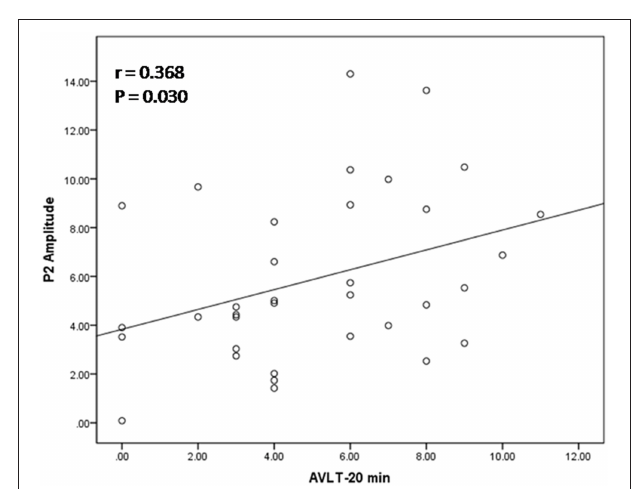
FIGURE 4 | Relation between P2 amplitude and score of auditory verbal learning test (recall after 20min). The scatterplot and best fit line ( r = 0.368 and p = 0.030) referred to Pearson’s correlation